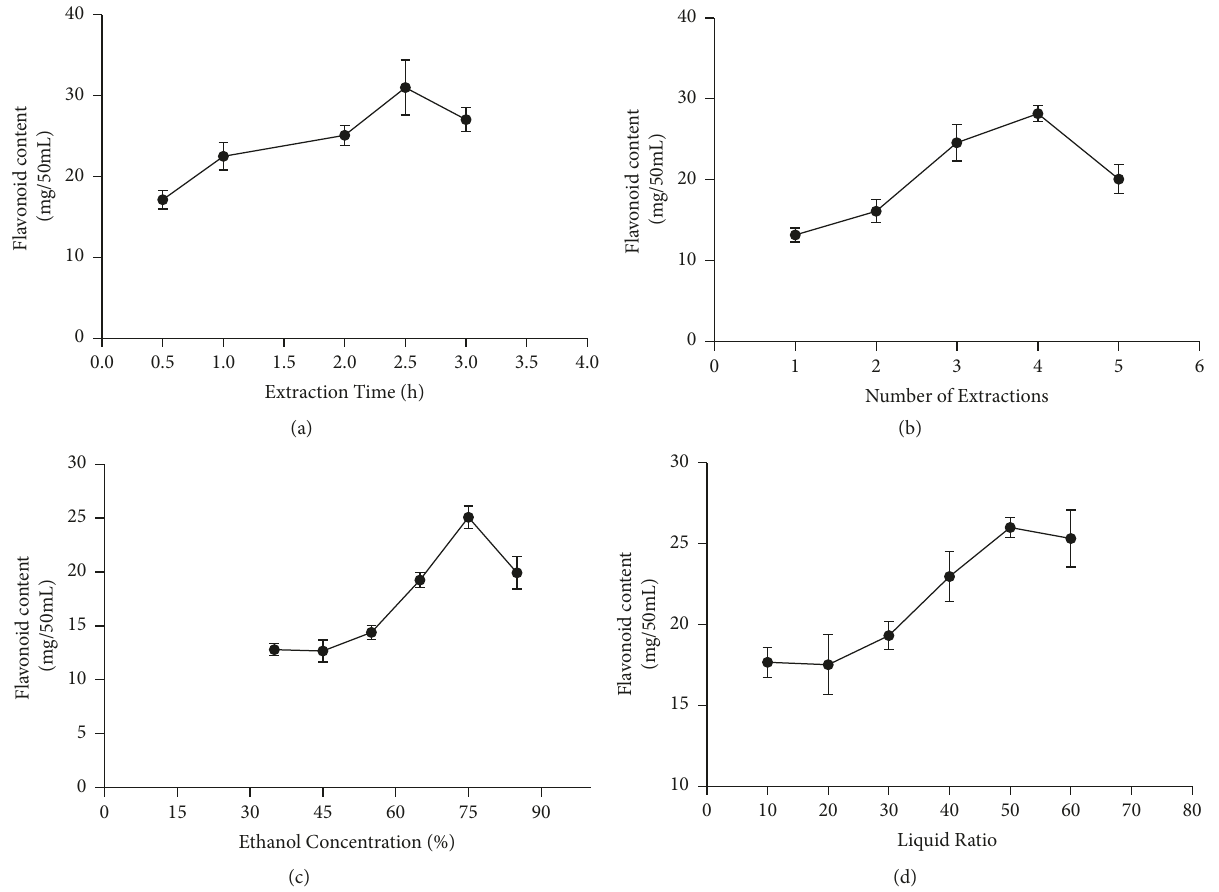
Figure 1: Effect of reaction conditions on the extraction efficiency of flavonoids: (a) extraction time, (b) number of extractions, (c) ethanol concentration, and (d) liquid